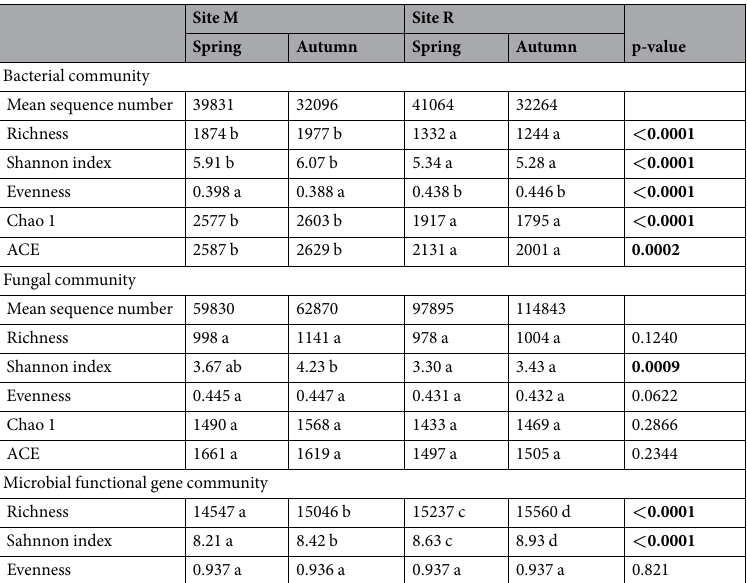
Table 2. Diversity characteristics of bacterial, fungal and microbial functional gene communities determined at the deciduous forest site M (545–570 m asl) and the coniferous forest site R (1,724–1,737 m) in spring and autumn. For ANOVA analyses, p-values in bold denote statistical significance (p ≤ 0.05); for Tukey’s HSD tests, mean values followed by different letters are significantly different (p ≤